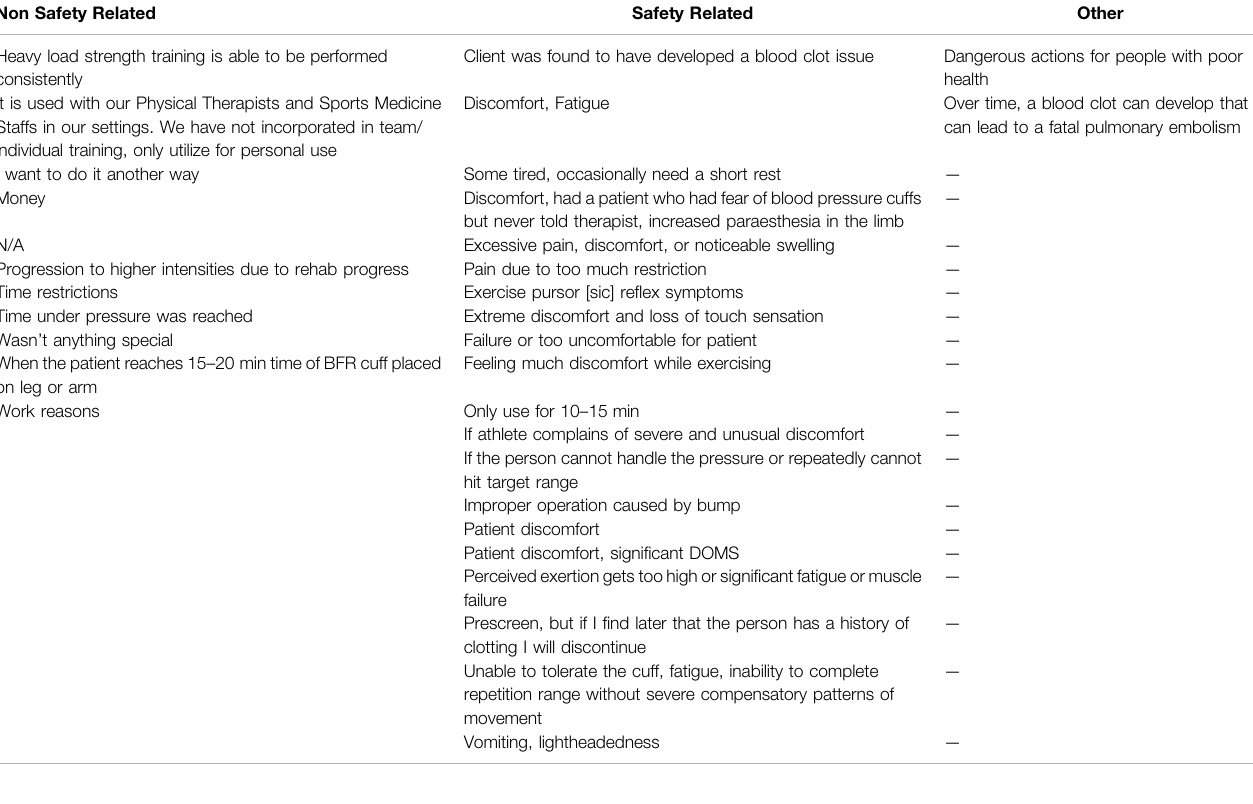
TABLE 6 | Reasons respondents discontinued BFR/KAATSU training.